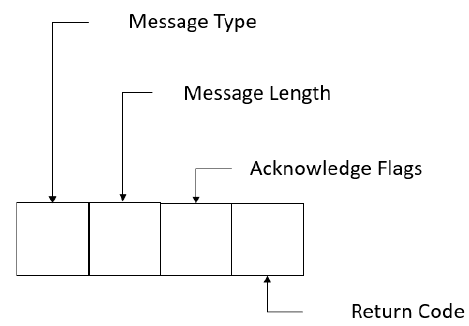
Figure 4. Connect ACK packet structure.